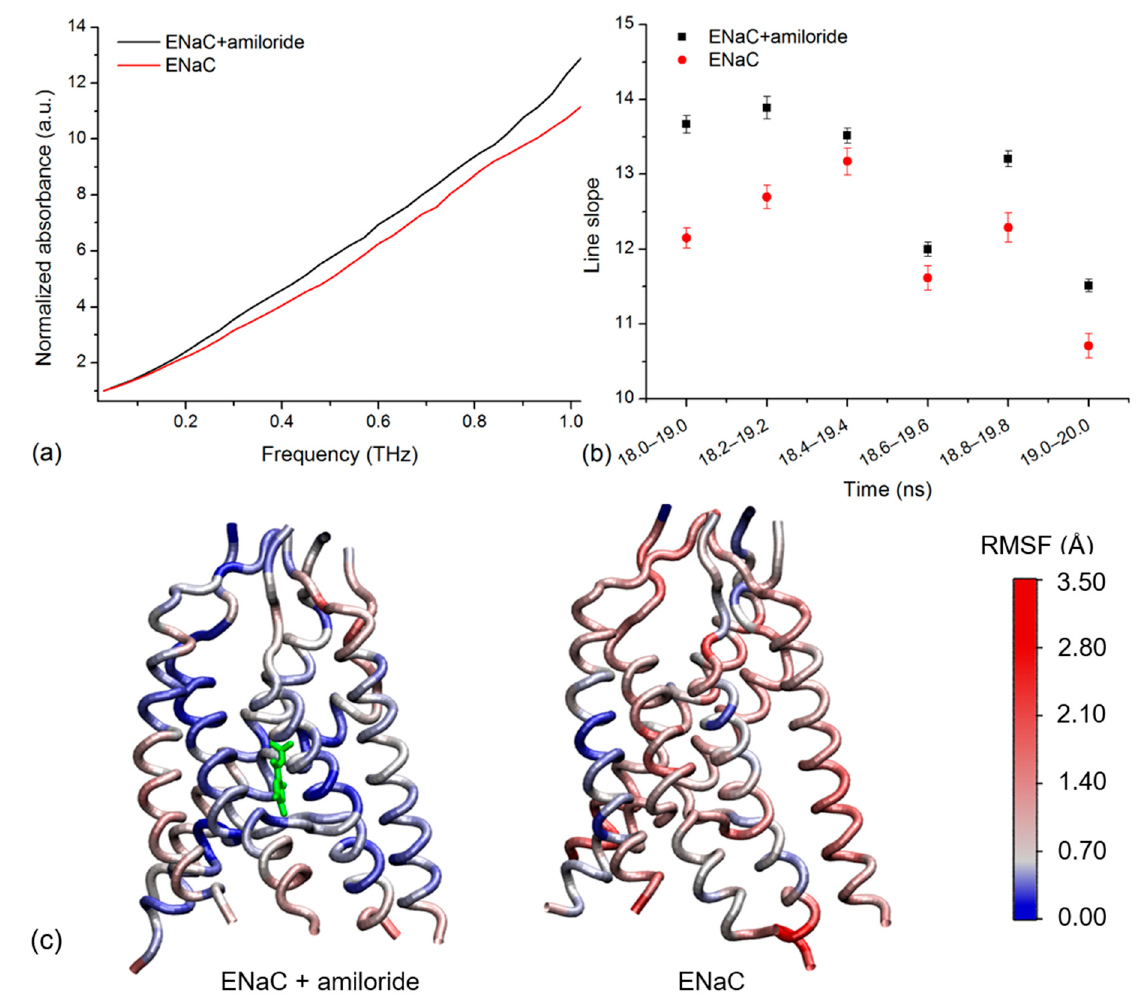
Figure 3. ( a ) The normalized simulated spectra of xENaC in the presence of amiloride (ENaC + amiloride) and in the absence of amiloride (ENaC) calculated over the last ns of simulation, between 19 and 20 ns; ( b ) The slopes of the lines that fit the normalized THz spectra of xENaC in the presence of amiloride (ENaC + amiloride) and without amiloride (ENaC) calculated in the 18–20 ns time range over trajectories of 1 ns, from 0.2 to 0.2 ns; ( c ) TM regions of xENaC in complex with amiloride (represented with green) and without amiloride colored according to the RMSF values of α Carbon atoms in the last ns of MD simulation (19–20 ns).